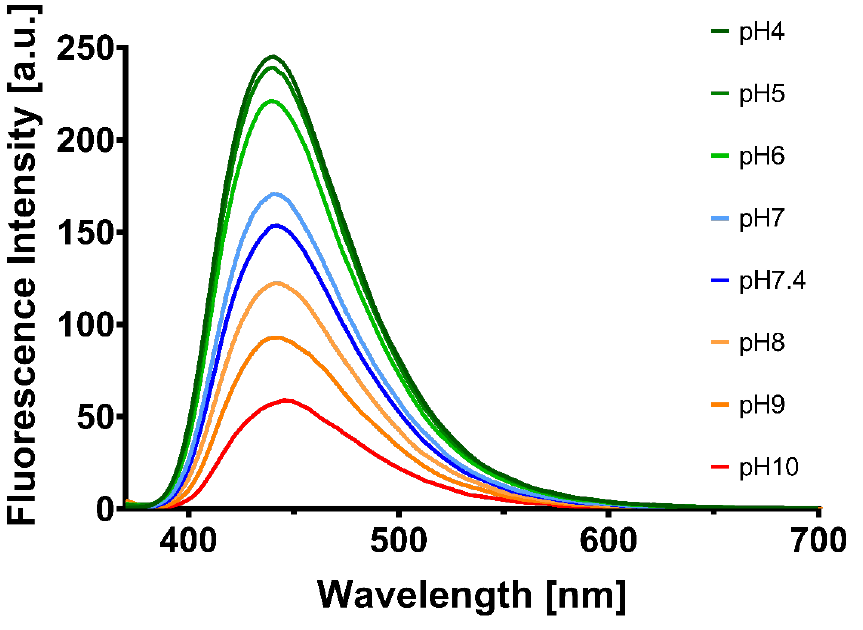
Figure 5. The stability of CQDs solutions in PBS at various pH values.